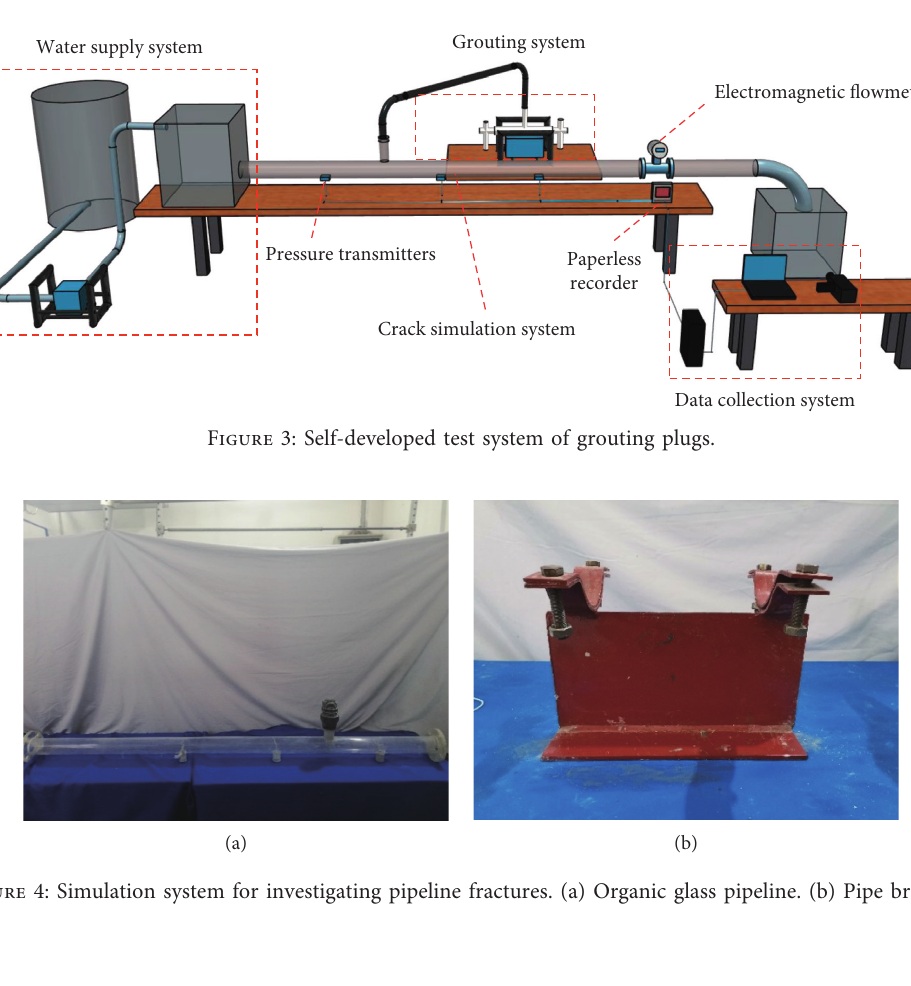
Table 2: Parameters of the pressure sensor and electromagnetic flowmeter.